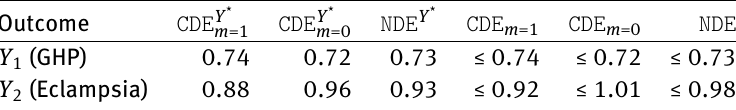
/ s Y = 0.95 , by Corollary 4.1, the bounds of true risk ratios 1 0